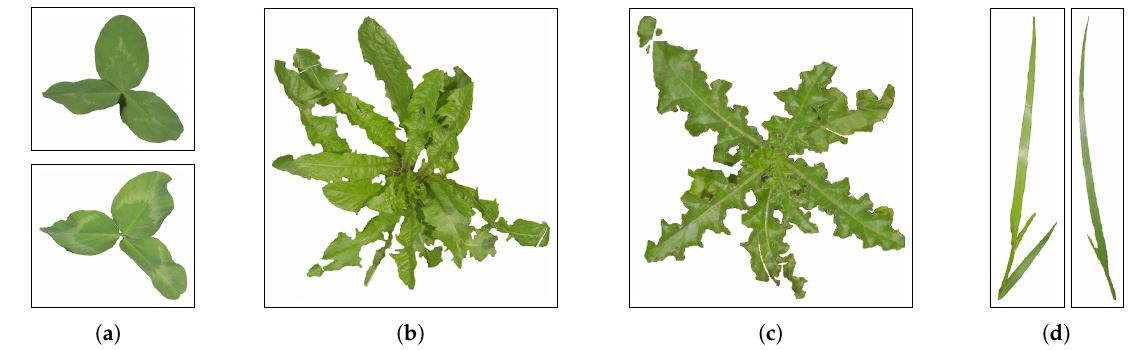
Figure 5. Samples of single plants that are used for simulating images. ( a ) clover; ( b ) dandelion; ( c ) thistle; and ( d ) grasses.